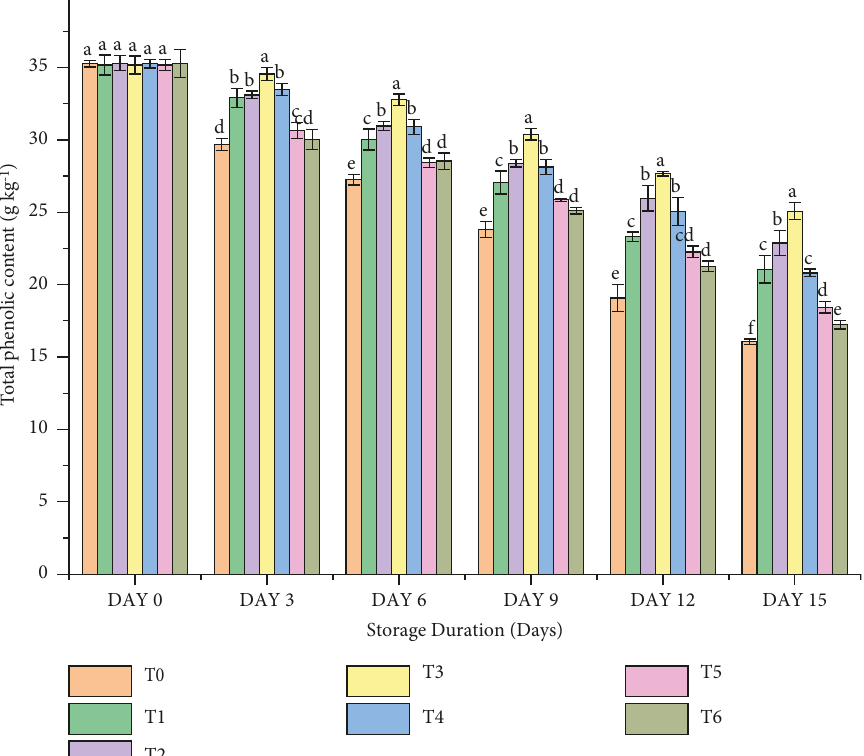
Figure 8: Effect of chitosan coating and cinnamon essential oil on total phenolic content of pomegranate arils during storage at 4 ± 1 ° C. Vertical bars represent the mean ± SD of 3 replicates. Error bars with different letters on the same storage period show a significant difference ( P ≤ 0 . 05). T0 � control; T1 � 1% chitosan+0.25% oil; T2 � 1% chitosan+0.5% oil; T3 � 2% chitosan+0.25% oil; T4 � 2% chitosan+0.5% oil; T5 � 3% chitosan+ 0.25% oil; T6 � 3% chitosan+0.5%